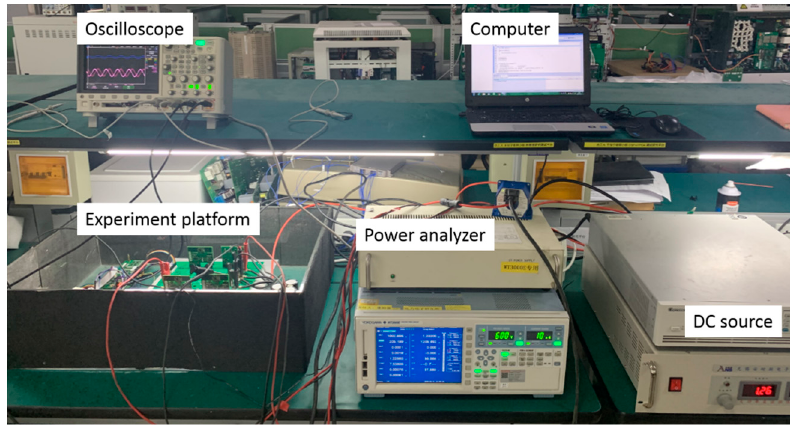
Figure 10. Photograph of the experimental platform.